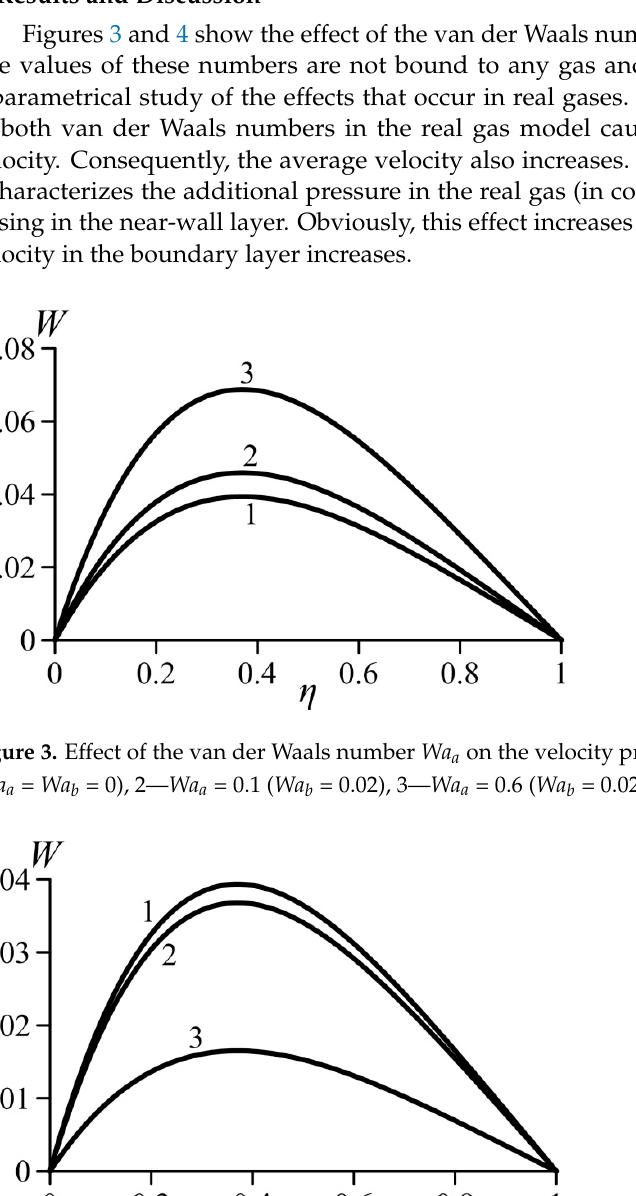
= βθ = βθ . 1—ideal . 1—ideal w w